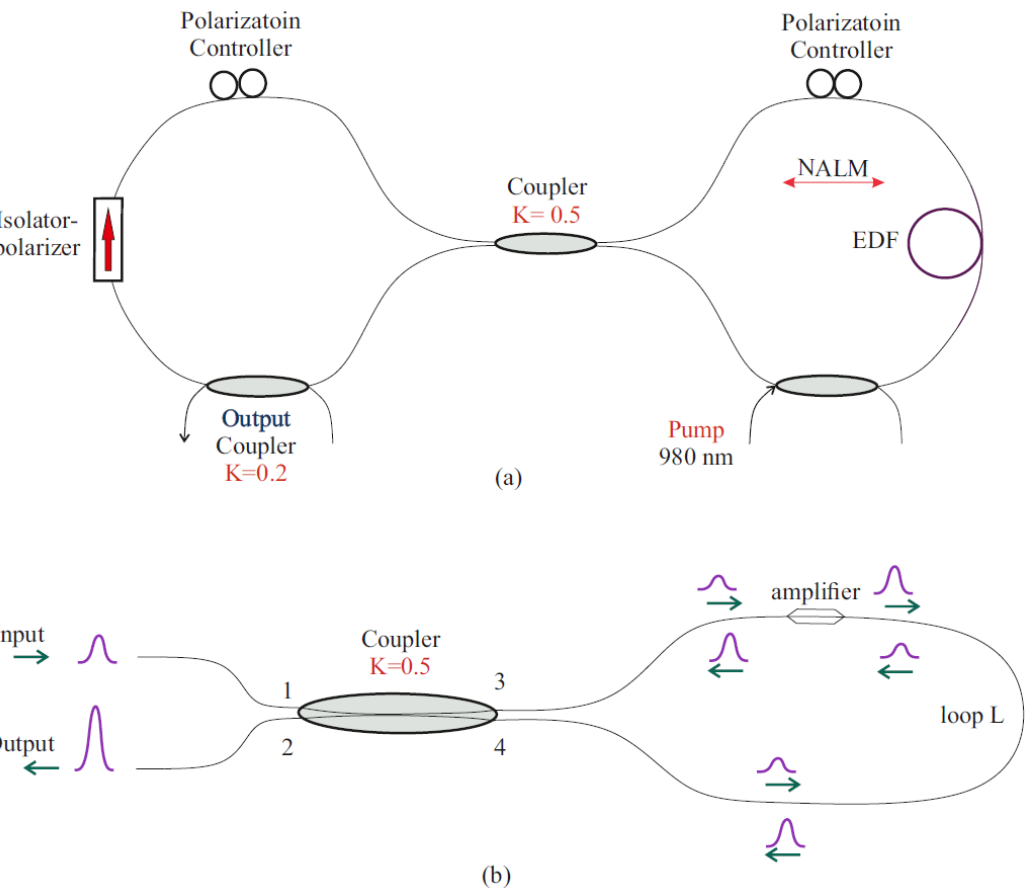
Figure 24. Layout of a laser using a nonlinear amplifying loop mirror and the scheme of its operation: ( a ) layout of a laser with a nonlinear amplifying loop mirror in the transmission mode and ( b ) a diagram of the operation of a nonlinear amplifying loop mirror.